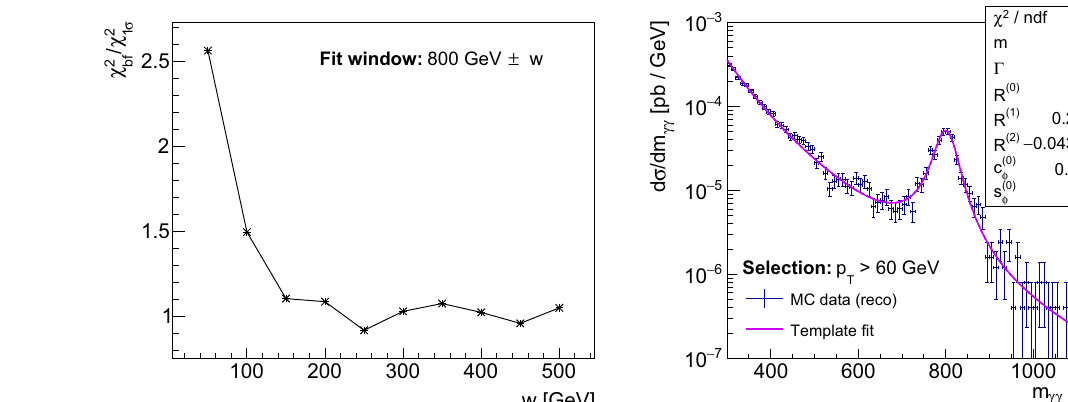
Fig. 13 Left: The variation of χ 2 window, for fits of the convolved second-order template functional formtoreconstructed MadGraph5_aMC@NLO